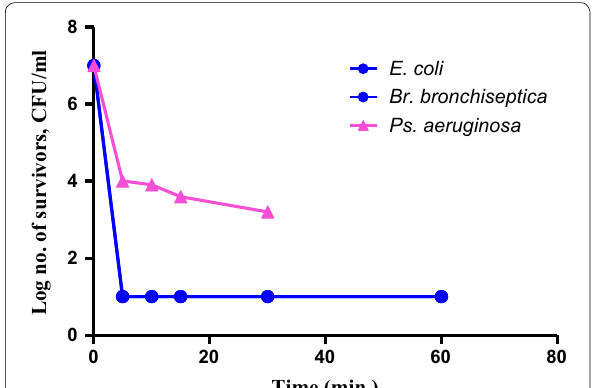
Fig. 4 Biocidal dynamics of OV EO (1% v/v) against three Gram negative bacteria